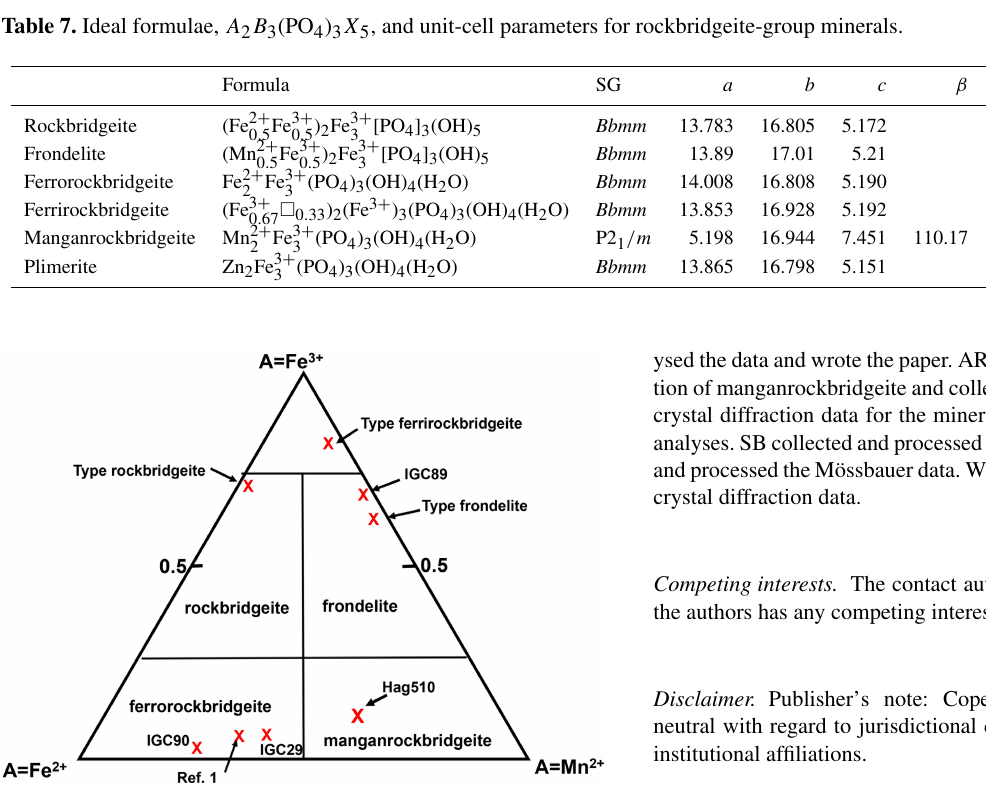
Figure 8. Rockbridgeite-group mineral phase fields, based on the occupation of the M 2 site by Mn 2 + , Fe 2 + and Fe 3 + (Grey et al.,